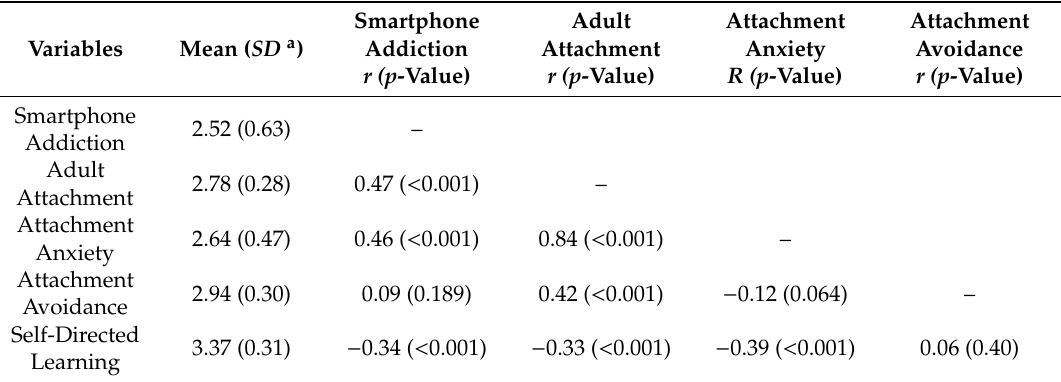
Table 2. Correlations between smartphone addiction, adult attachment, and self-directed learning ( n =